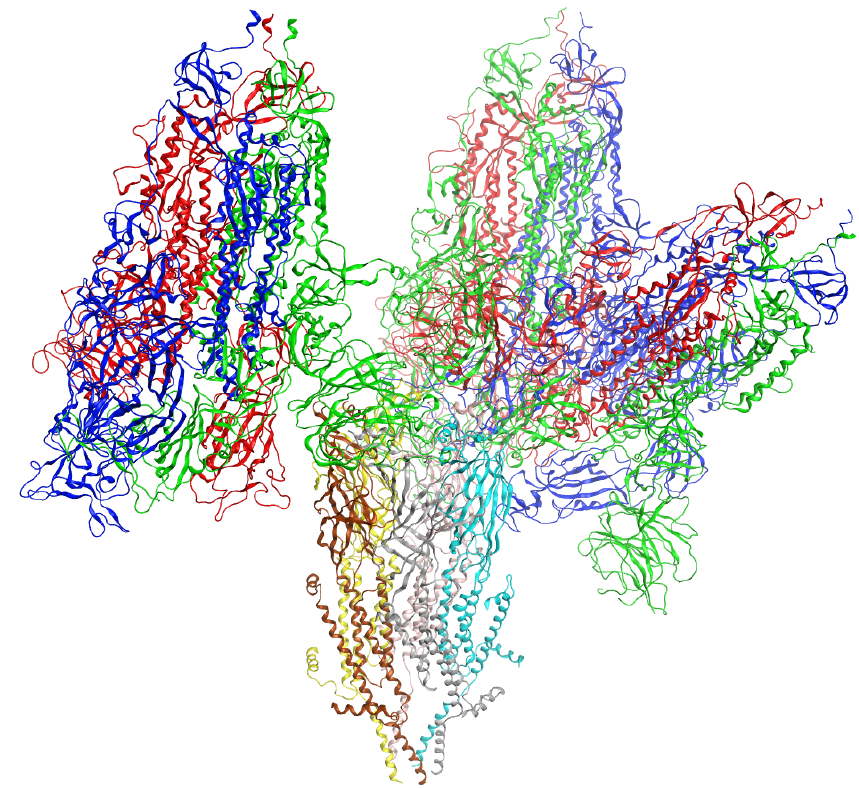
Figure 3. α7 appears in the bottom region in the complex with the main spike on the left, Omicron in the middle, and the Delta variant on the right. The α7nAChr pentamer is colored in cyan (chain A), pink (chain B), yellow (chain C), brown (chain D), and gray (chain E). Regarding all the spikes we can see, chain A (dark blue), chain B (red), and chain C (green).